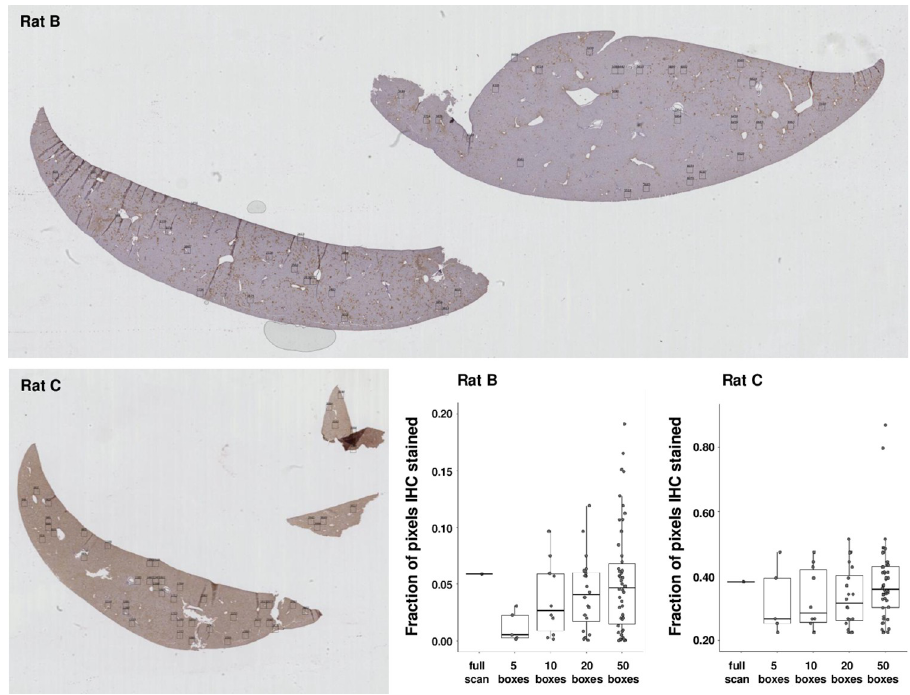
Fig 3. Fraction of DAB-stained tissue pixels in each of 2 test slides quantified by whole slide analysis versus random sampling with 5, 10, 20, or 50 boxes per slide. With an increasing number of boxes, the median fraction of DAB-stained pixels approaches the fraction calculated by whole slide analysis. Random sampling dramatically cuts processing time and reveals the level of heterogeneity in tissue staining.